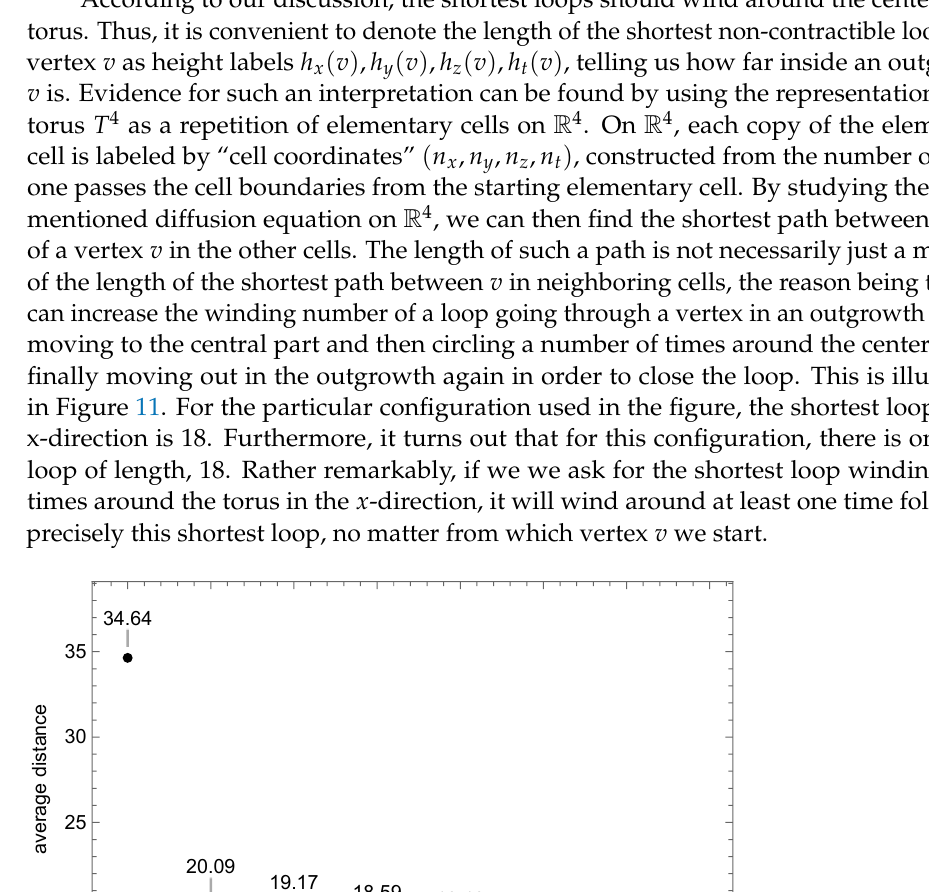
Figure 11. Distance from a starting simplex to its copy in cell same simplex to its copy in cell Already for n = 8, the minimal value of 18 is